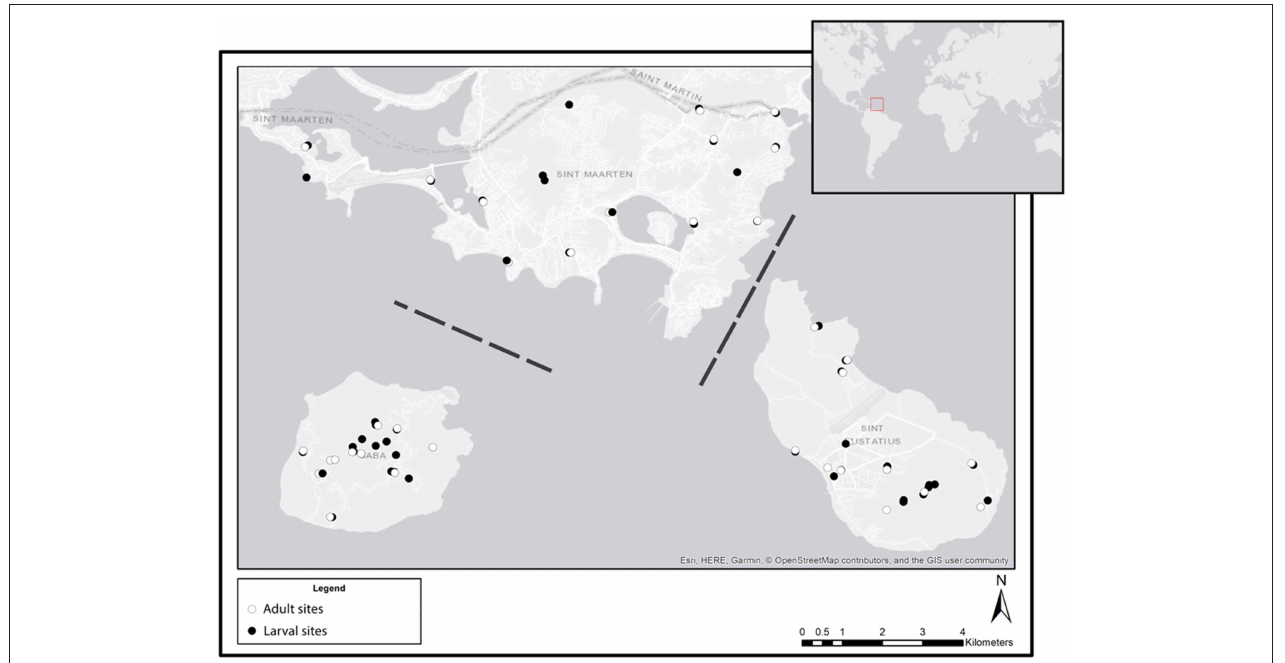
FIGURE 1 | Overview of all sampling sites at each of the three sampled Caribbean islands: St. Maarten (top), Saba (bottom left), and St. Eustatius (bottom right). White symbols indicate sites where adults were sampled, black symbols indicate sites where larval (dipping) and eDNA (water and sediment) samples were collected. Dashed lines indicate that the distance between islands is not to scale (Esri,